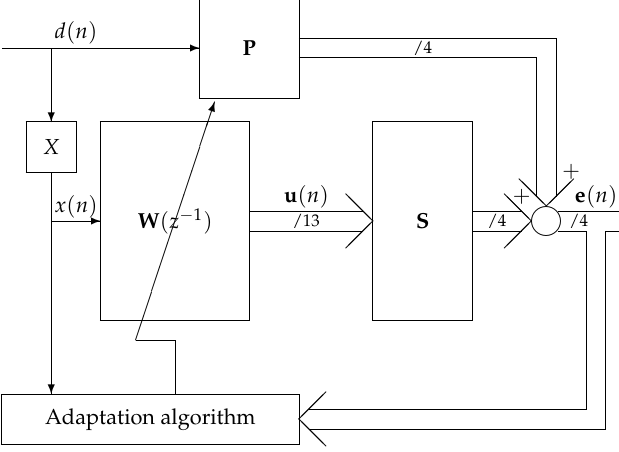
Figure 1. Simplified ANC system block diagram.